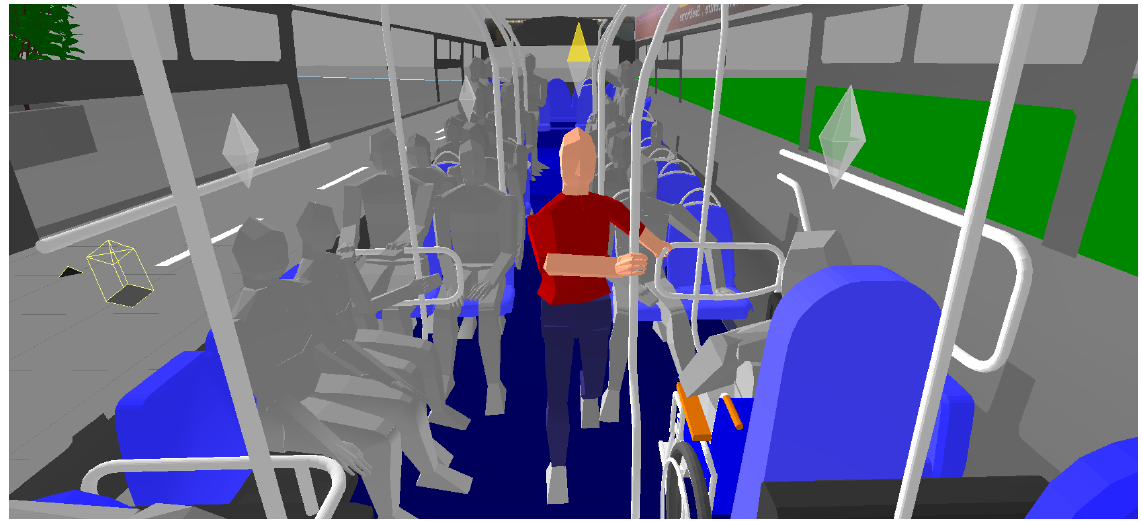
Figure 11. P13 moves forwards gripping the next left hand upright with the right